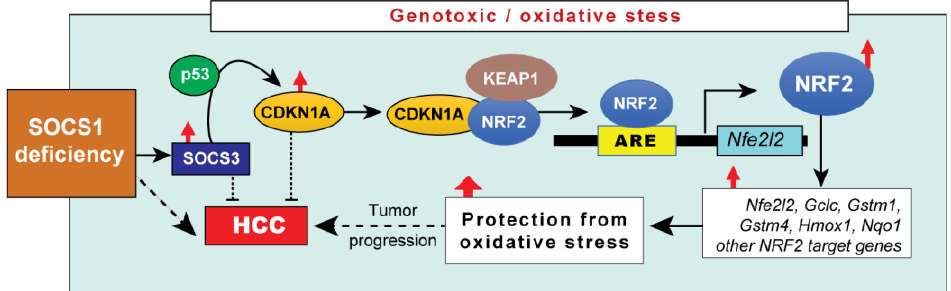
Figure 5. Mechanisms underlying increased HCC development in SOCS1-deficient hepatocytes. Under conditions of genotoxic and oxidative stress, SOCS1-deficient hepatocytes upregulate SOCS3, presumably to compensate for the loss of certain SOCS1-dependent functions. However, SOCS3 promotes p53 activation and induces CDKN1A, which interacts with NRF2, leading to NRF2 activa- tion and induction of NRF2 target genes. As protein products of these genes confer protection from oxidative stress, they could facilitate the adaptation of SOCS1-deficient HCC to increased cancer cell metabolism and disease